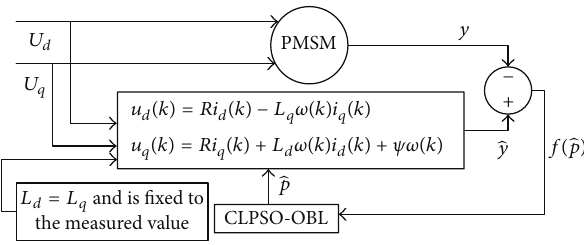
Figure 1: PMSM parameter estimation